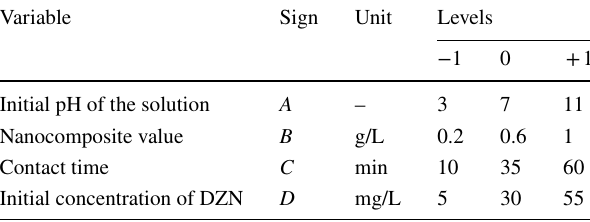
Table 2 Selected levels and code for Box–Behnken test design Variable Sign